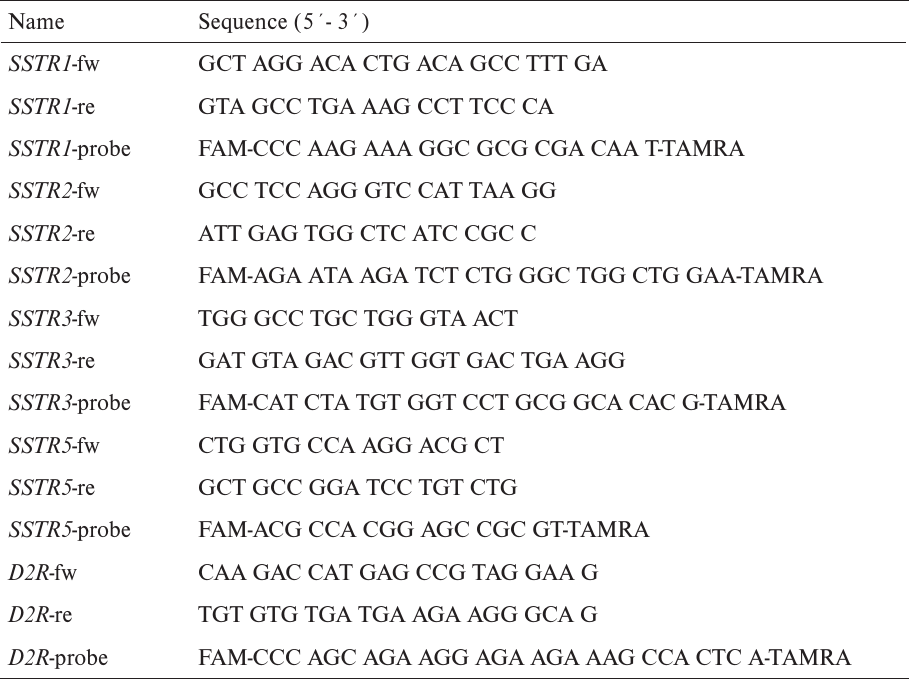
Table 1. Sequences of the used primers and probes.